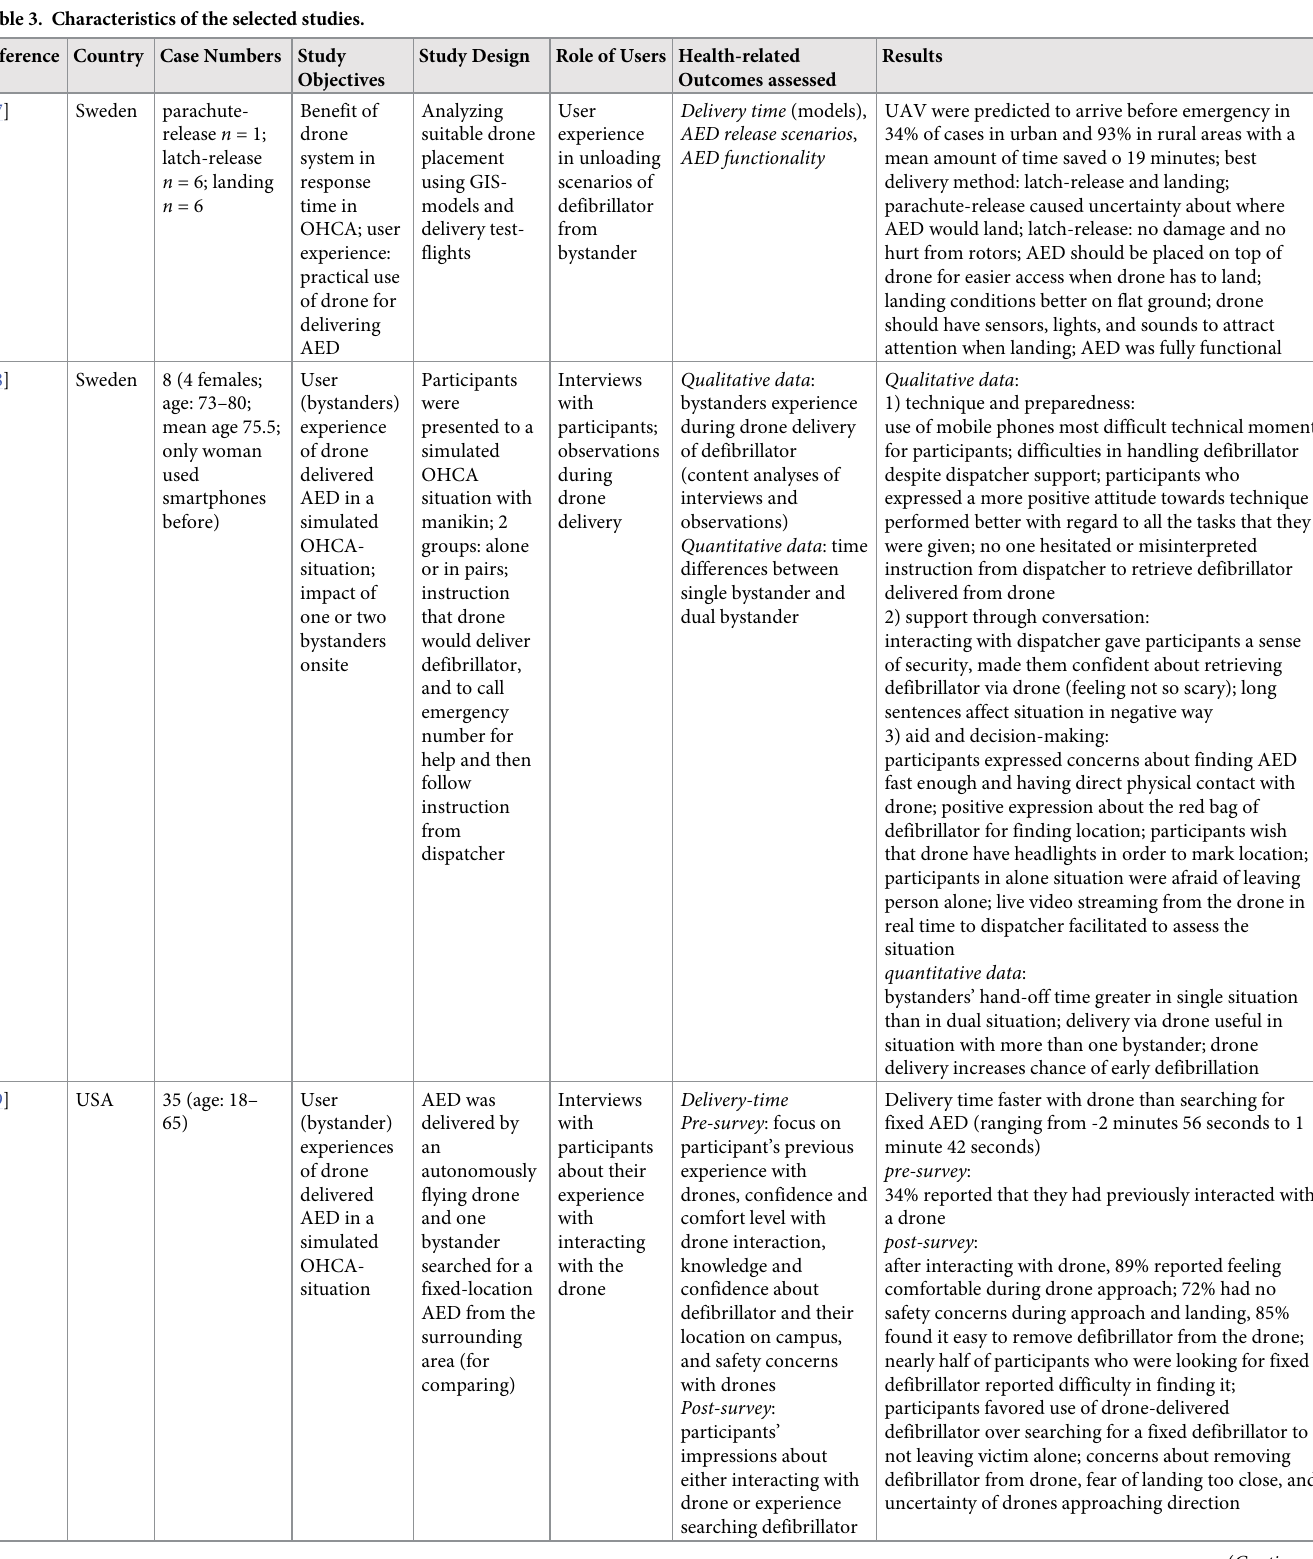
Table 3. Characteristics of the selected